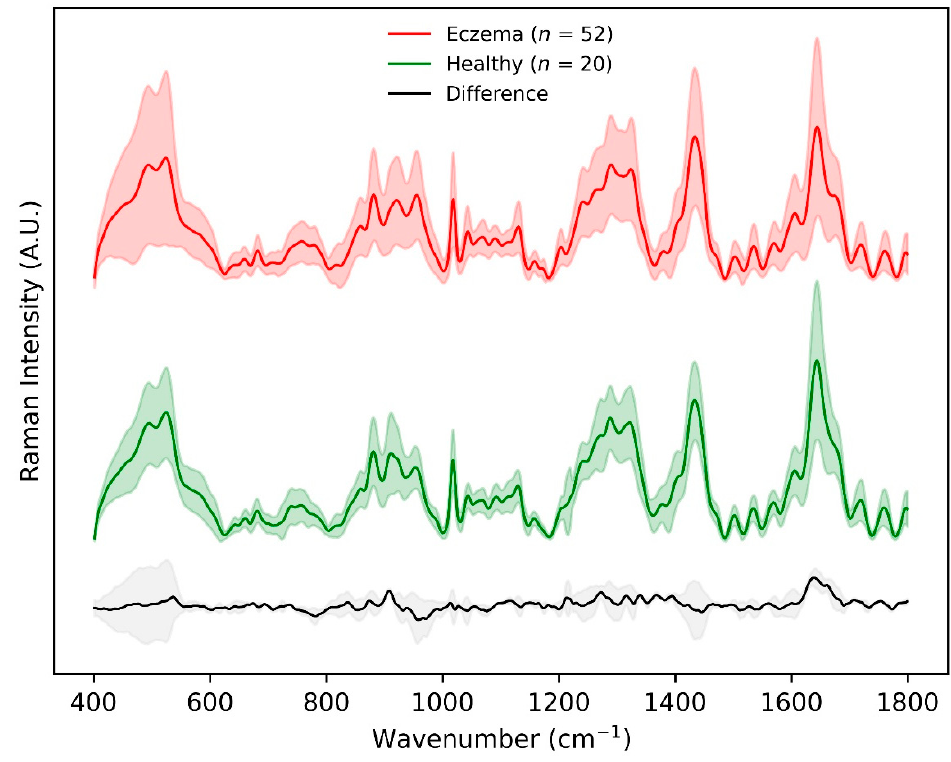
Figure 2. Preprocessed Raman spectra achieved using CRM system within the fingerprint 400–1800 cm − 1 wavenumber range for eczema ( n = 52, top) and healthy ( n = 20, middle) subjects. The difference between the two spectra is shown in grey at the bottom. Shaded region depicts 1 standard deviation variation in the data while the solid line depicts the means of the spectra.